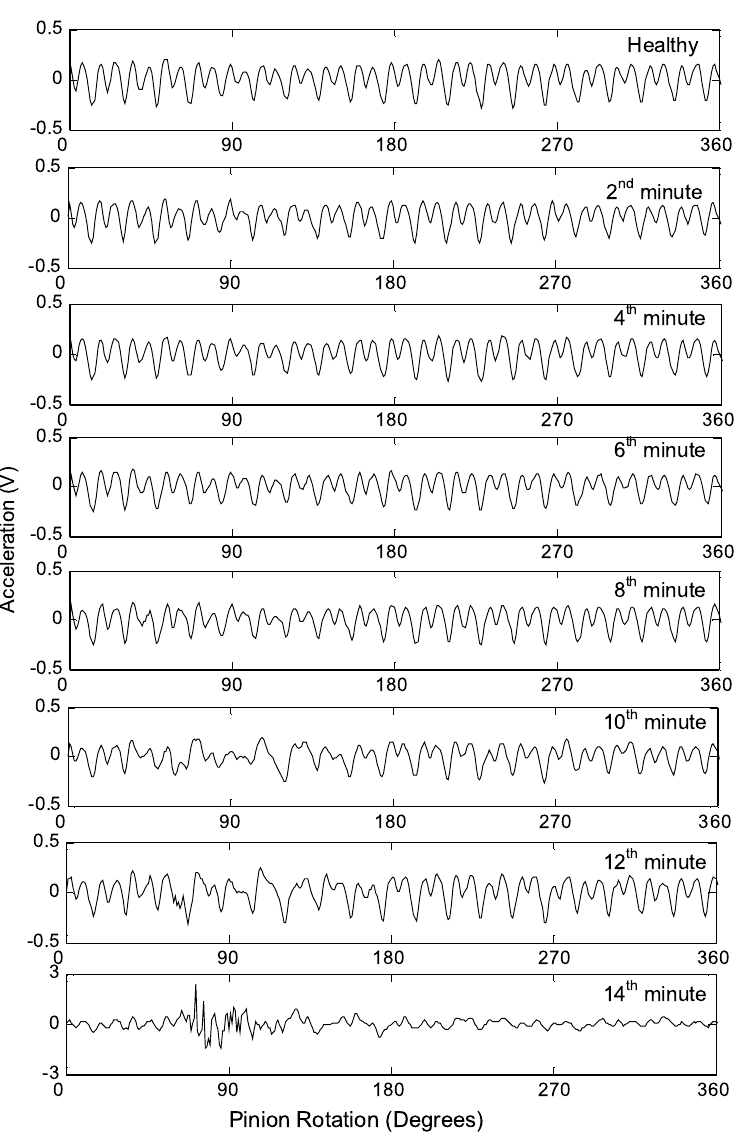
Fig. 7. Averaged gear vibration accelerations monitored at two-minute intervals during the fatigue